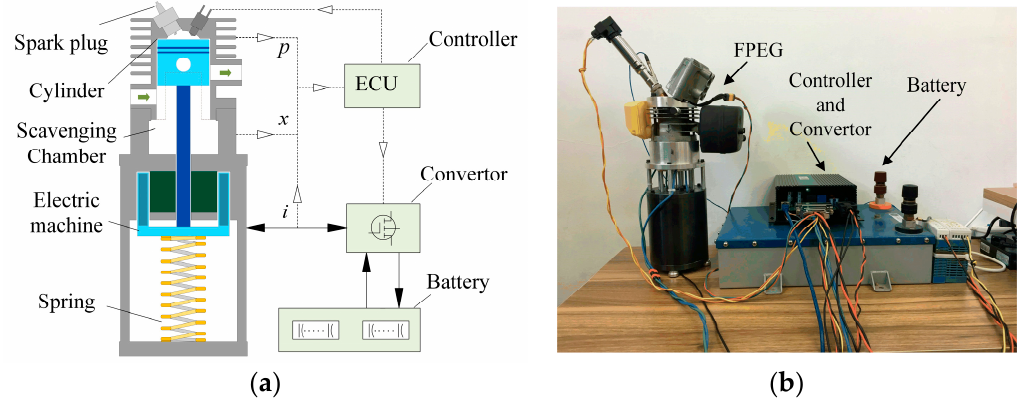
Figure 1. Configurations of the free-piston engine generator (FPEG), ( a ) structure, ( b ) prototype.